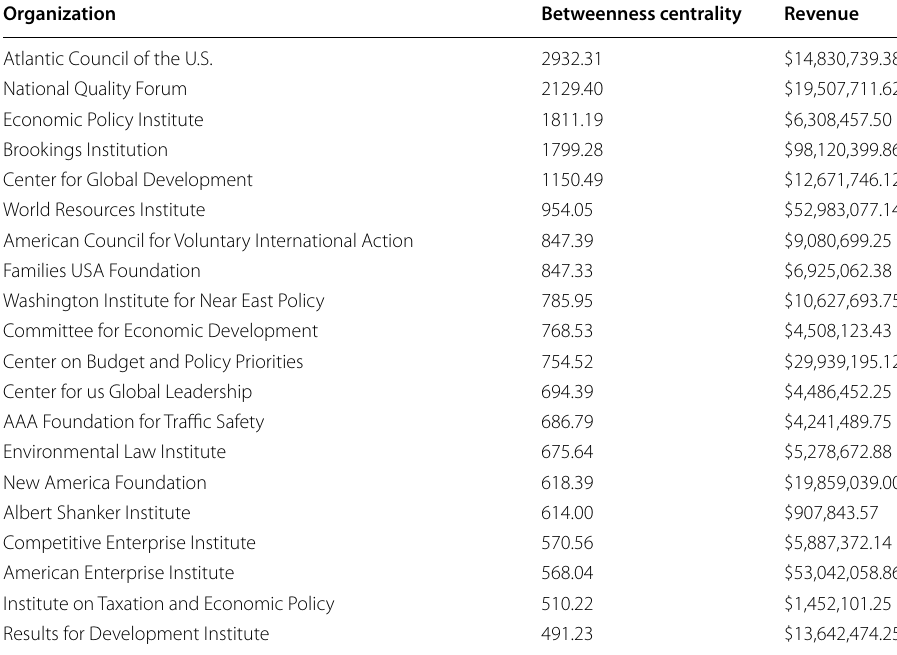
Table 3 Most central policy planning organizations Organization Betweenness centrality Revenue Atlantic Council of the